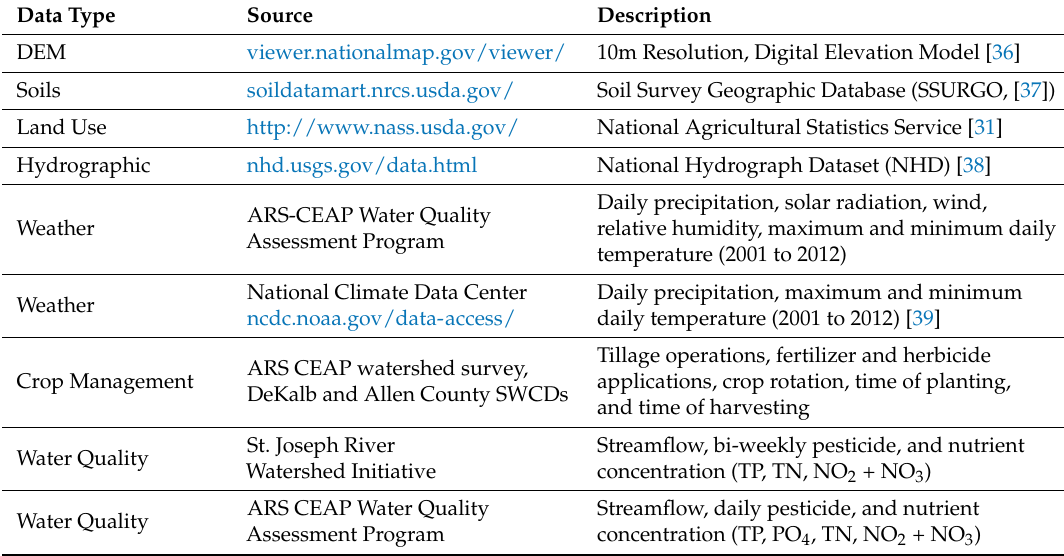
Table 2. Model input data.